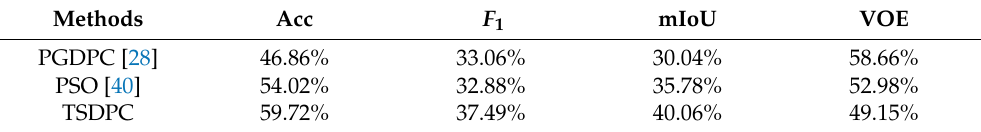
Table 3. Evaluation indicators data statistics of three clustering algorithms on the public dataset-2. Methods